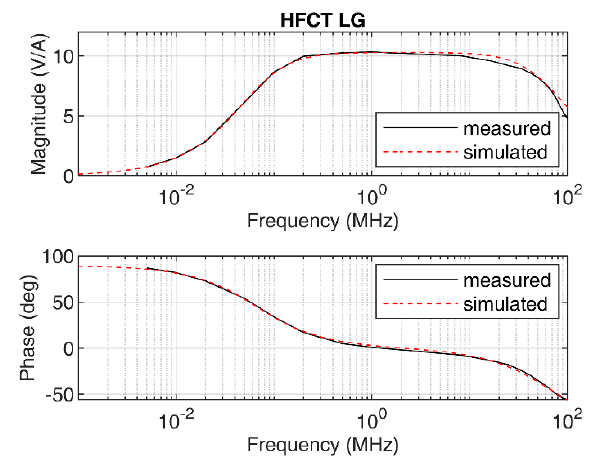
Figure 3. HFCT_LG sensor frequency response, measured and simulated.